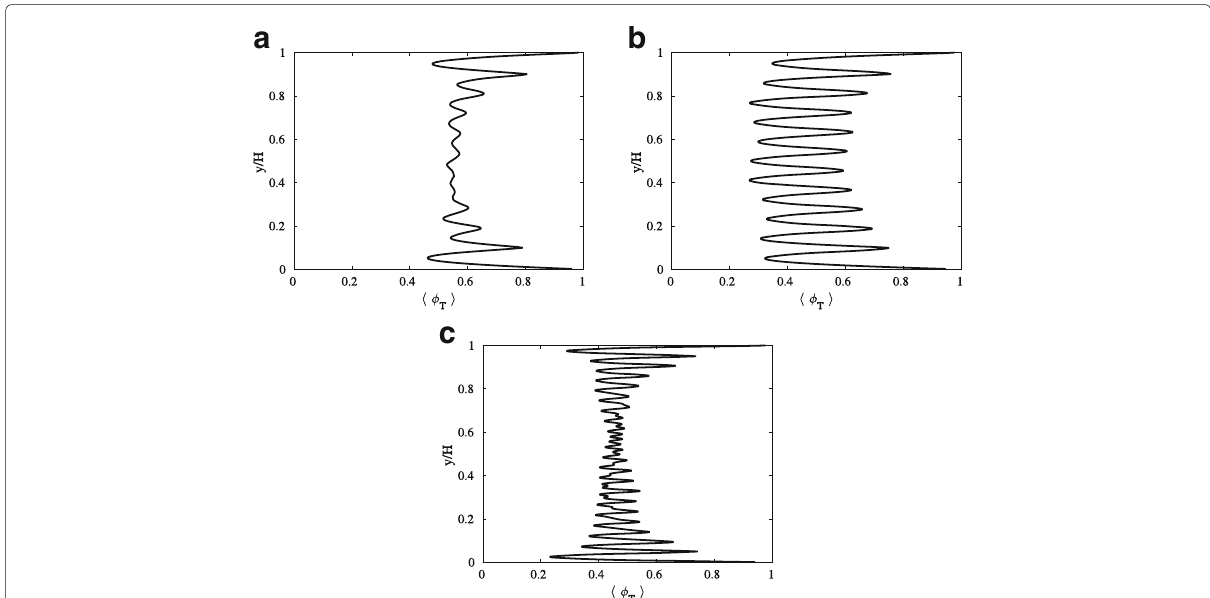
Fig. 6 Porosity profiles averaged in the streamwise and spanwise directions and time for the three simulation scenarios: a Re = 10 and φ v = 0.42, b Re = 10 and φ v = 0.54, and c Re = 40 and φ v = 0.54